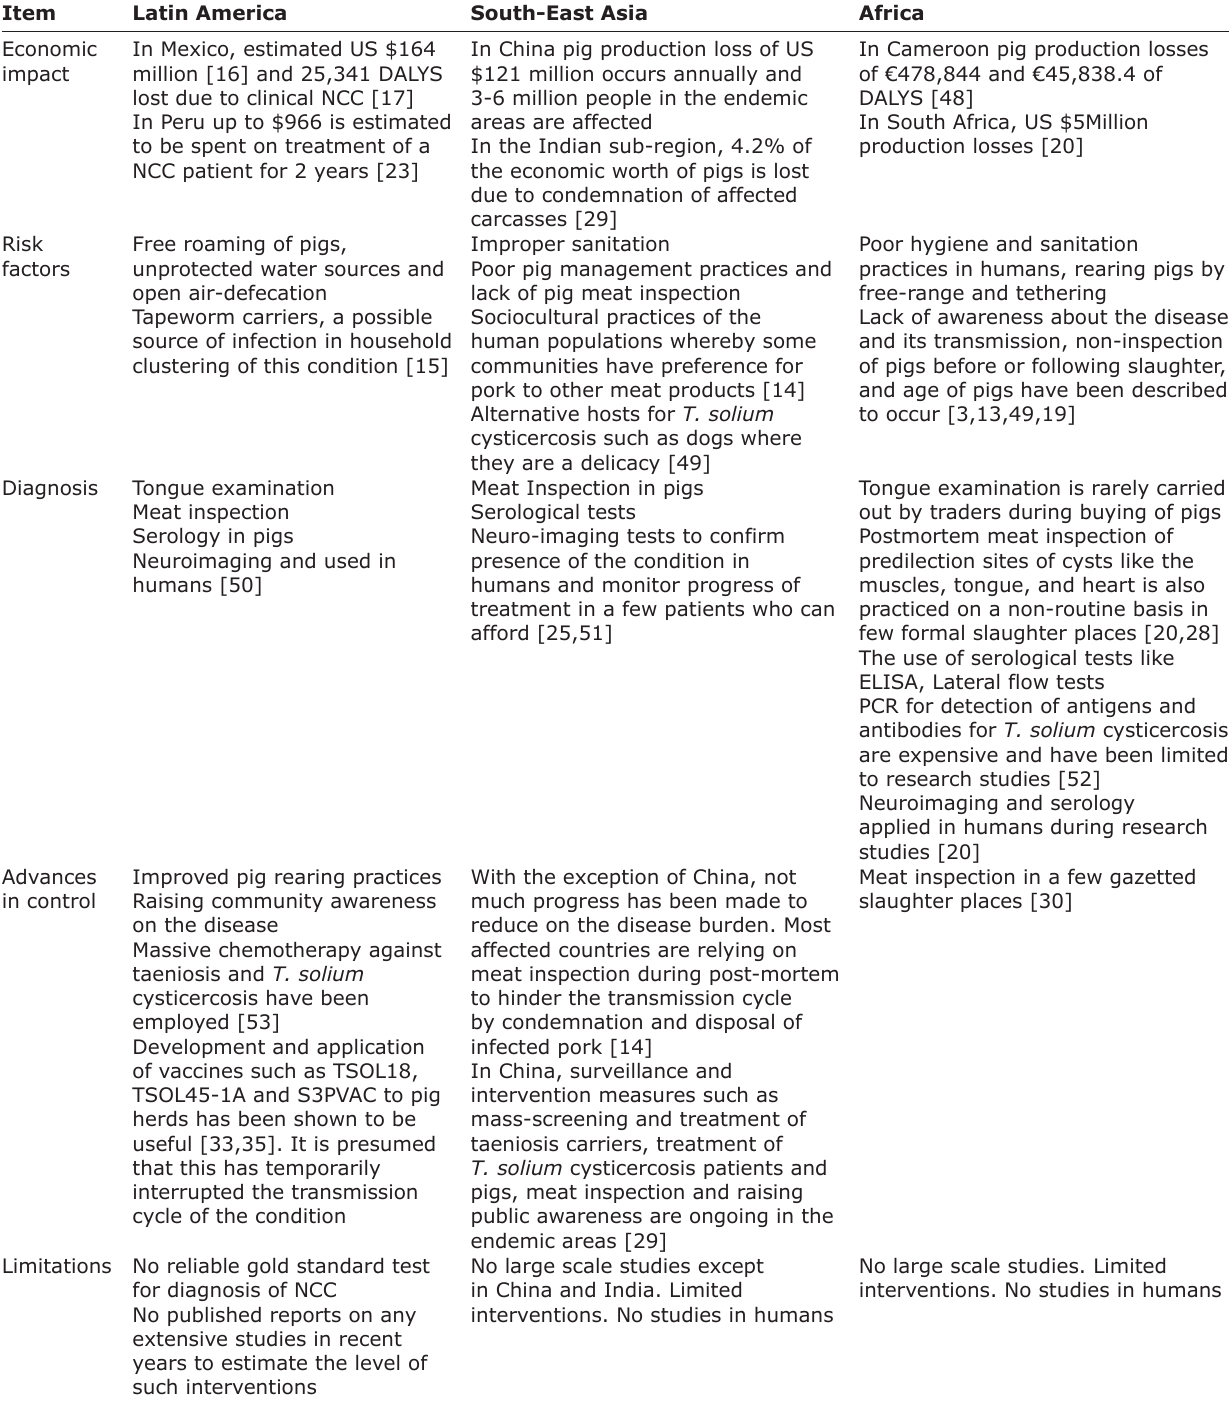
Table-2: A summary of the status of T. solium cysticercosis in Latin America, South-East Asia, and Africa. Item Latin